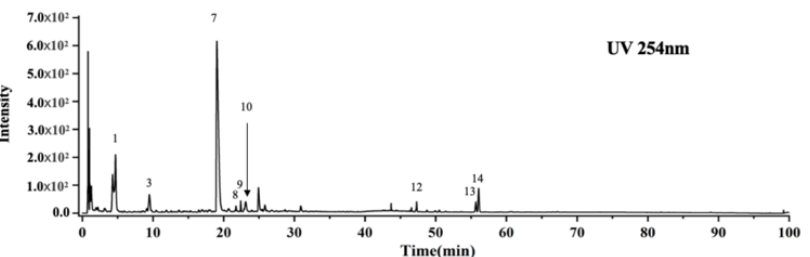
Figure 1. UPLC-Q-TOF-MS analysis of ethanolic extracts of Echinacea Purpurea . 1. Caftaric acid; 2. Coutaric acid; 3. Cis-fertaric acid; 4. Rhodioloside D; 5. Trans-fertaric acid; 6. N-Acetyl-DL-tryptophan; 7. Chicoric acid; 8. Quercetin 3-O-robinobioside; 9. Rutin; 10. Isoquercitrin; 11. Trihydroxyoctadecanoic acid; 12. 2,4-Undecadiene-8,10-diynoic acid isobutylamide; 13. Dodeca-2E,4E,8Z,10E-tetraenoic acid isobutylamide; 14. Dodeca-2E,4E,8Z,10Z-tetraenoic acid isobutylamide; 15. Hydroxyhexadecanoic acid; 16. Linolenic acid; 17. Linoleic acid; and 18. Palmitic acid.